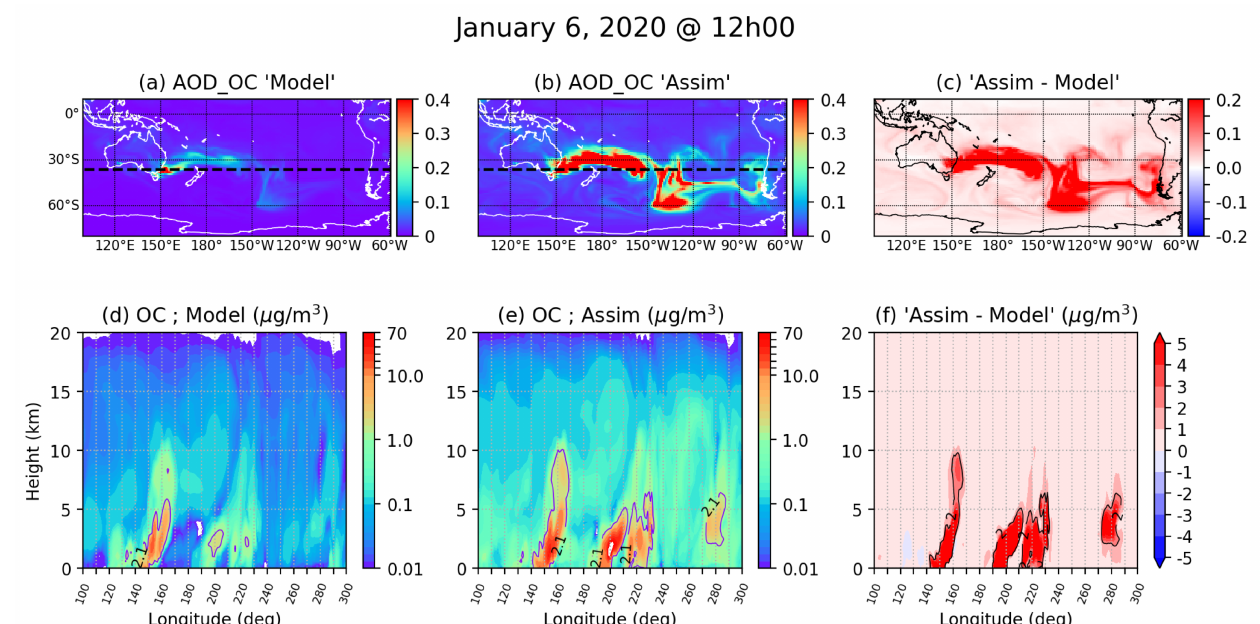
Figure 10. ( Top ): Aerosol Optical Depth of Organic Carbon (OC) over the Australian continent issued from the model free run ( a ) and the MODIS assimilated field ( b ) for 6 January 2020. The difference between ( b ) and ( a ) is presented in ( c ). ( d ) The zonal cross-section of OC concentration issued from the model free run at 37.5 ◦ S between 110 ◦ and 300 ◦ in longitude and between 0 and 20 km in the vertical. Part ( e ) is the same as ( d ) but for the MODIS assimilated field. The differences between the assimilation and the model free run fields are presented in ( f